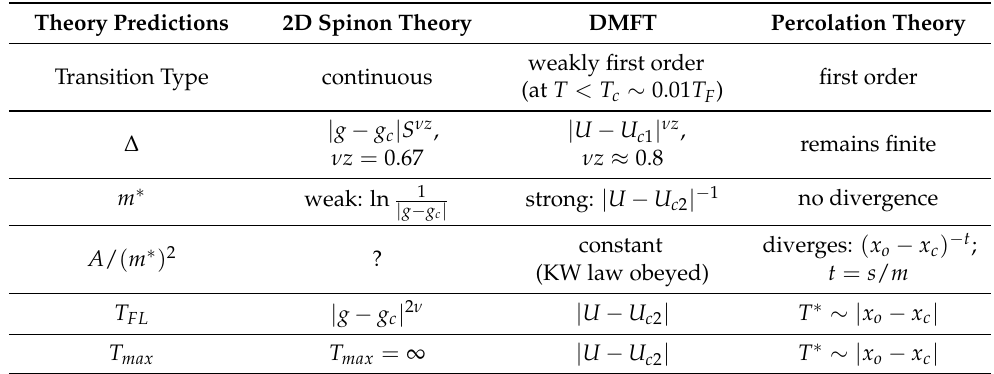
Table 2. A summary of predictions from competing theoretical pictures. The expected transition type differs between the three pictures, with observable differences in the behavior of the mass enhancement m ∗ , the Kadowaki–Woods ratio A / ( m ∗ ) 2 , the destruction of the Fermi liquid at T FL , and the appearance of a resistivity maxima at T max . Details are provided in the text